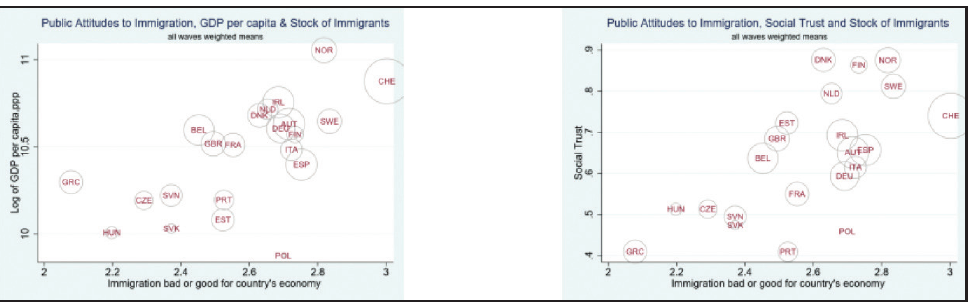
Figure 2 Sentiments toward immigration, standards of living, social trust, and size of for- eign stock